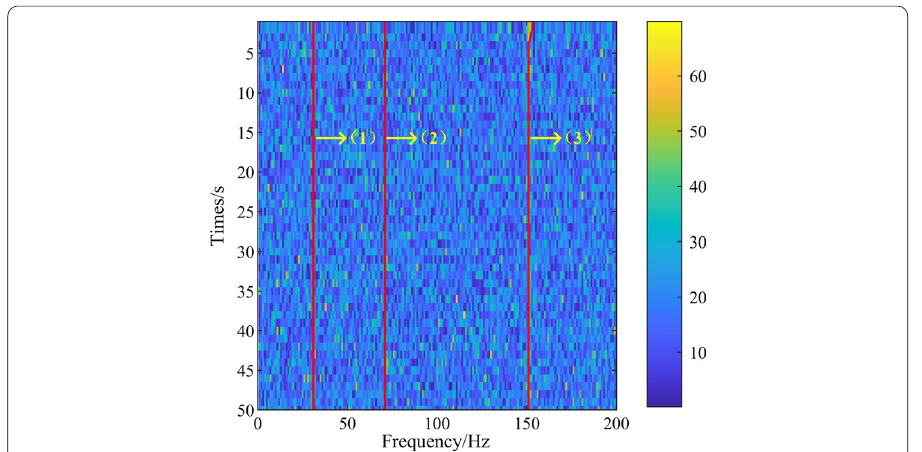
Fig. 7 Line-spectrum-extraction results of optimal path algorithm at